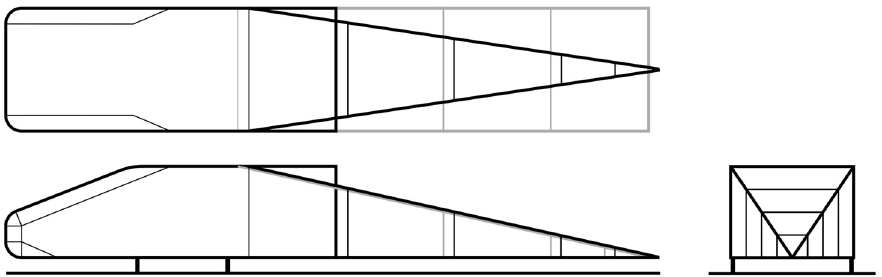
Figure 1. Windsor Body with streamlined tail in 2D and 3D configurations.